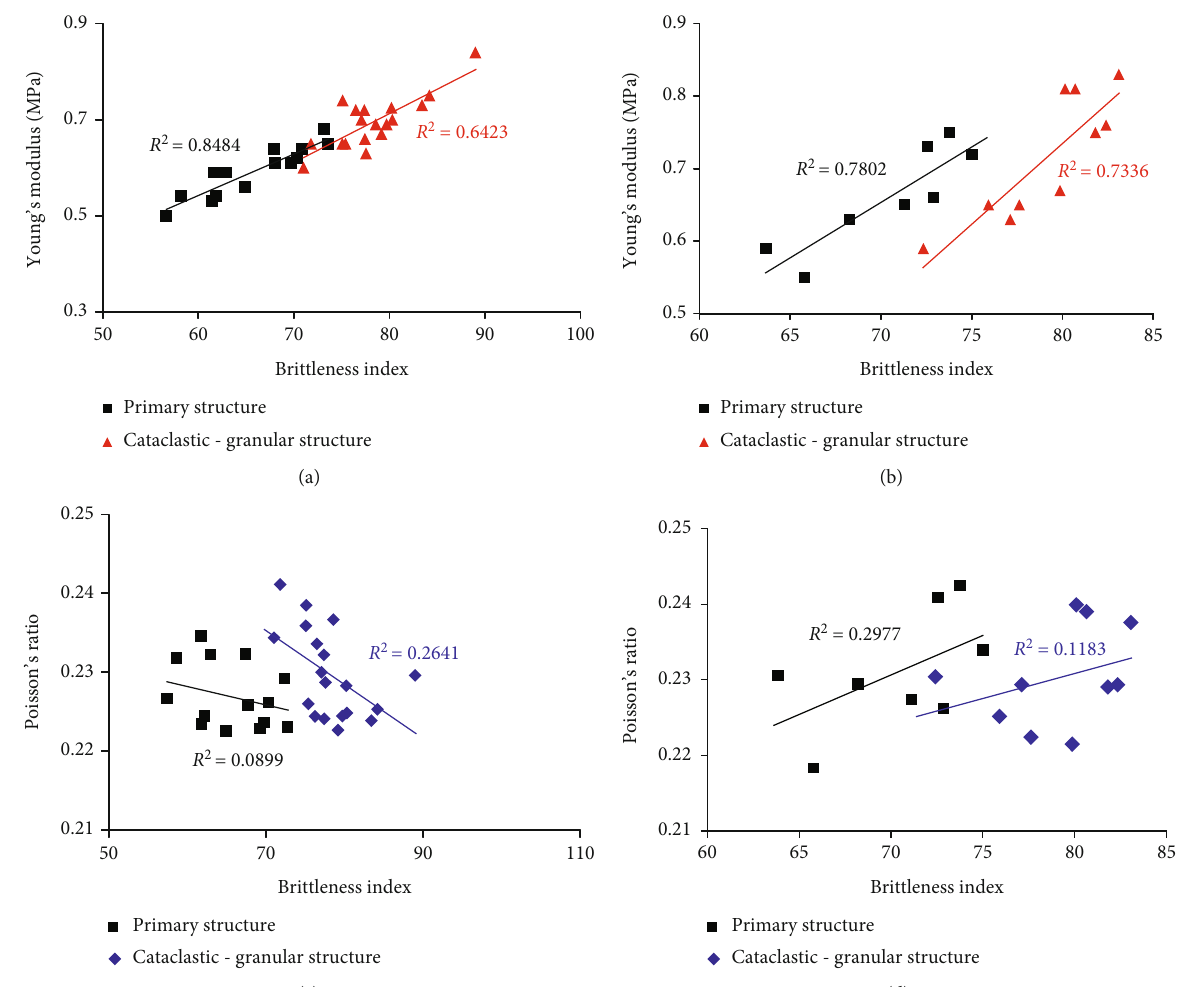
Figure 3: Relationship between mechanical parameters and the brittleness index of No. 3 and No. 15 coal: (a, c) No. 3 coal and (b, d) No. 15